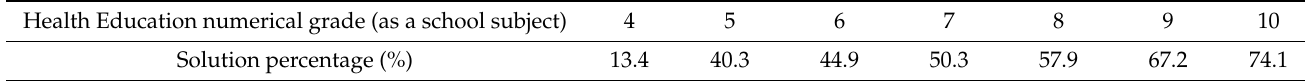
Table 2. The association between HE grades and success in the HL